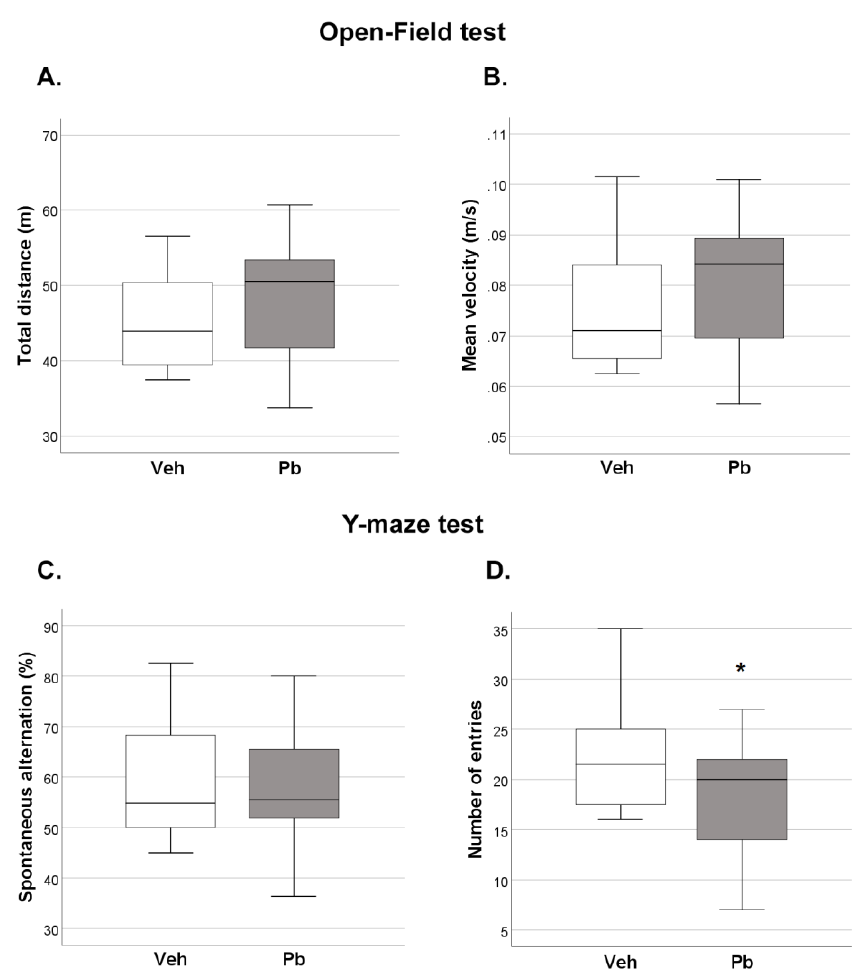
Figure 3. Effects of Developmental Pb Exposure on Locomotor Activity and Spontaneous Alternation Assessed in Open-Field (OF) and Y-Maze Test, Respectively. ( A ) Distance and ( B ) mean velocity in 10-min OF exploration; ( C ) Spontaneous alternation; and ( D ) number of arm entries in 5-min Y-maze test. Data are sex-pooled represented; n = 16 (7 females and 9 males)/group; * p < 0.05.